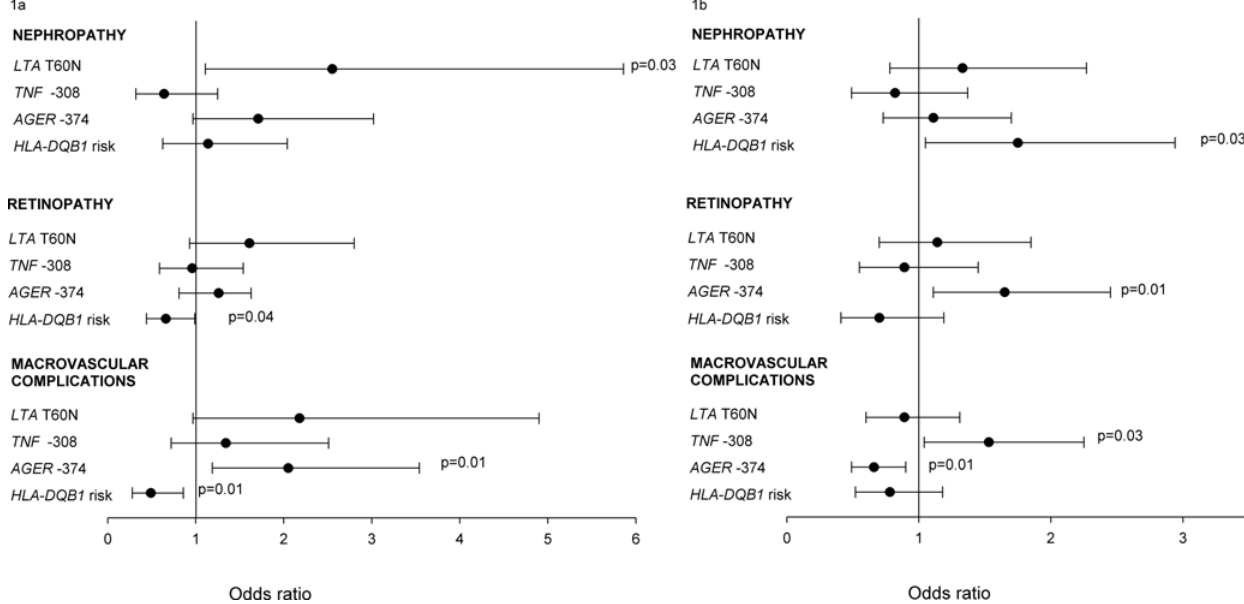
Figure 1. Logistic regression analysis in type 1 (1a) and type 2 (1b) diabetic patients with LTA T60N (C R A), TNF -308 G R A, AGER -374 T R A polymorphisms and HLA-DQB1 risk genotypes as independent and diabetic complication as dependent variable. Age, systolic and diastolic blood pressure, sex, previous/current smoking are included in all models. BMI is included in the models for nephropathy and macrovascular disease, duration in the models for nephropathy and retinopathy and age at diagnosis in the model for macrovascular disease.